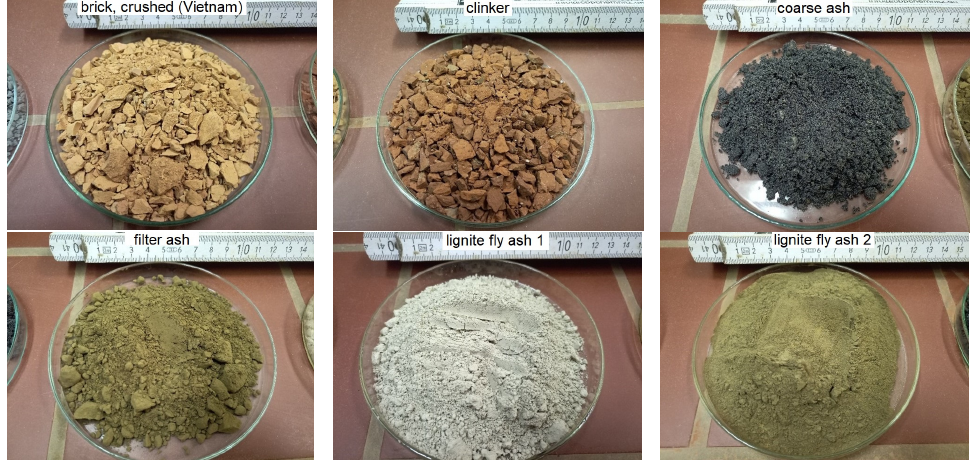
Figure 2. Potential secondary m-sand substitutes: crushed brick, crushed clinker; and secondary materials to substitute cement: lignite filter ash, coarse ash, and two types of fly ash (Figure source: Radek Kucera).